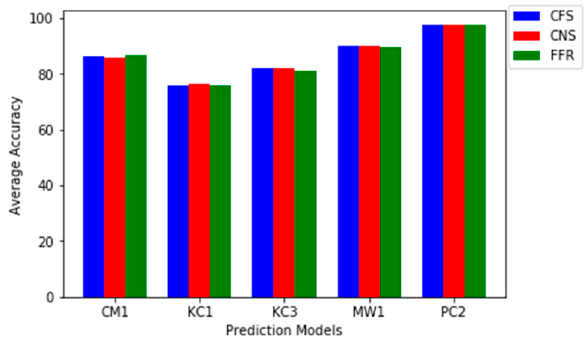
Figure 6. Performance of Feature Selection Method on each Dataset.